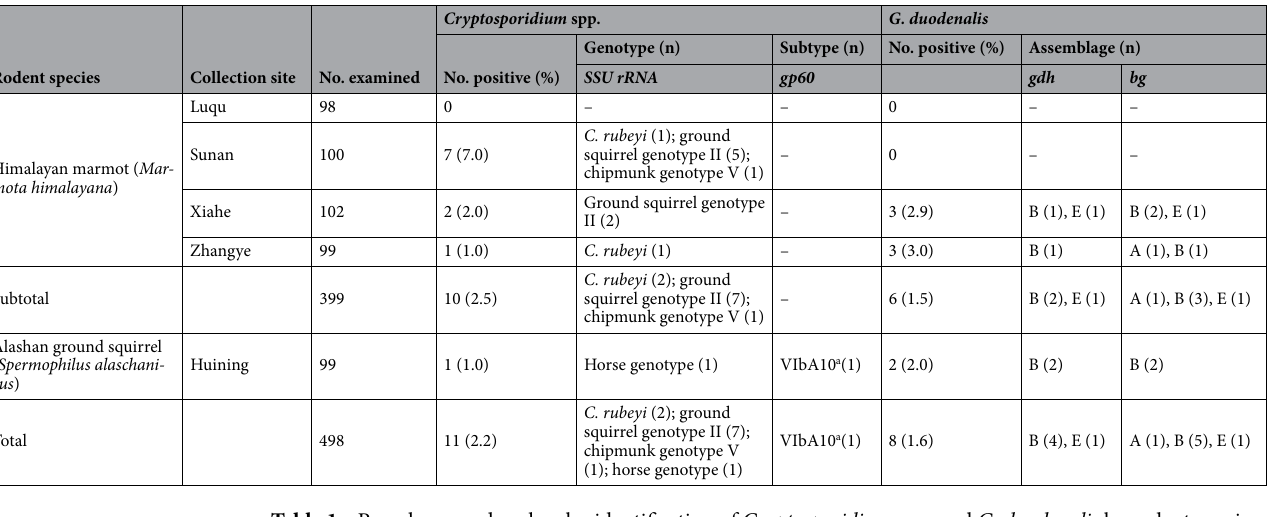
Table 1. Prevalence and molecular identification of Cryptosporidium spp. and G. duodenalis by rodent species and collection site. a Novel